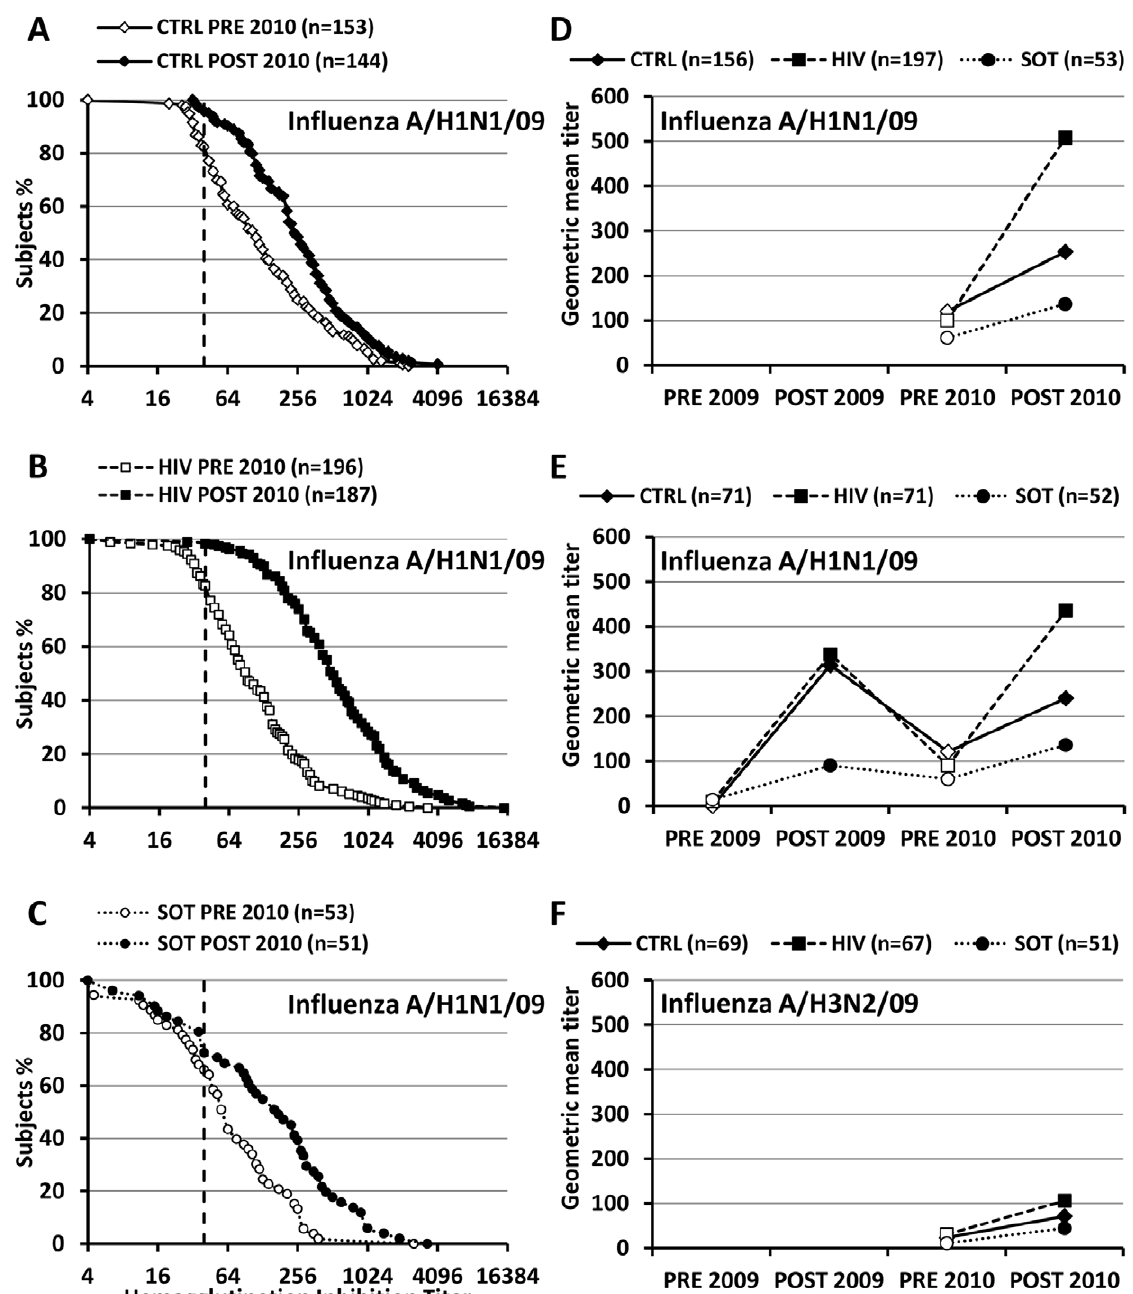
Figure 1. Distribution and kinetics of antibody titers. A–C. Blood was collected before and 4 weeks after 1 dose of non-adjuvanted 2010/2011 seasonal influenza vaccine. Antibody titers were assessed by hemagglutination inhibition (HAI). The results were expressed as the reciprocal of the highest dilution showing a positive HAI (see Methods). The vertical dotted line represents the seroprotection threshold (titer 1:40). The curves represent the distribution of individual antibody titers in each group. D-F: Geometric mean HAI titers to influenza A/09/H1N1 (D, E) and A/09/H3N2 (F) were measured before (pre-2009) and after (post-2009) immunization with 1 (controls) or 2 (patients) doses of AS03-adjuvanted pandemic vaccine, and before (pre-2010) and after (post-2010) 1 dose of non-adjuvanted 2010/2011 seasonal influenza vaccine. D: All patients followed in 2010/2011. E- F: Patients followed for 2 consecutive seasons.